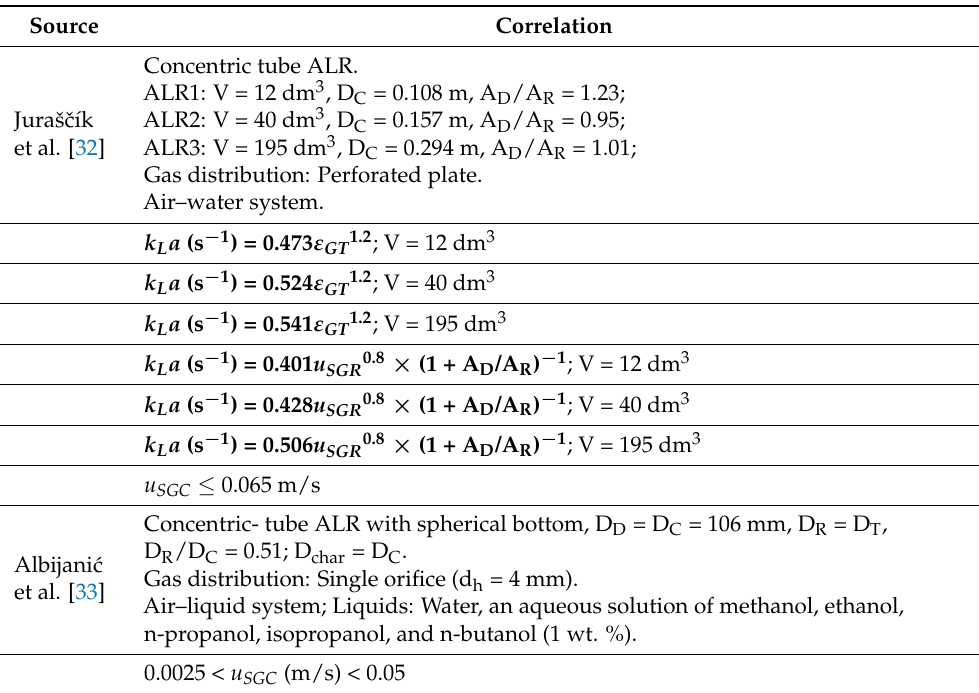
Table 4. Overall volumetric mass transfer coefficient k L a —selected published correlations;